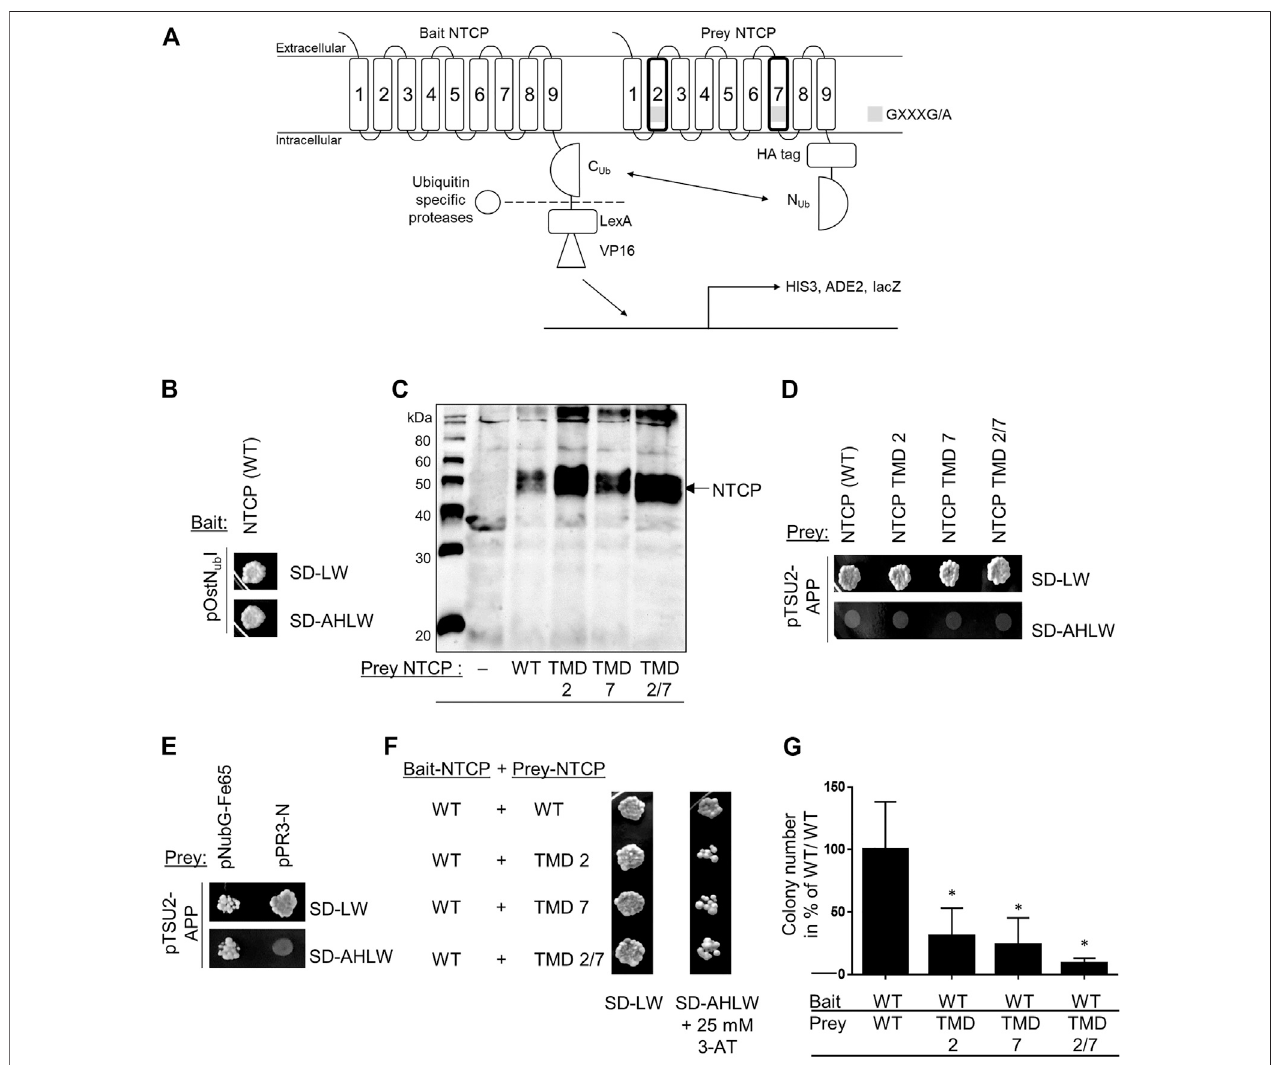
FIGURE 1 | Functional NTCP homodimerization in the MYTH system. (A) The MYTH system is based on the fusion of the C-terminal part of ubiquitin with the N-terminalpart leadingtothe separation ofthetranscriptional factors LexA-VP16 byubiquitin-speci fi cproteases and activation ofgenesresponsiblefor thesynthesis of histidine and adenine. (B) Yeast cells were co-transformed with the wild-type (WT) NTCP-C ub -LexA-VP16 bait and the pOstN ub I control prey constructs. Growth was analyzed on SD-LW plates (lacking leucine and tryptophan) and on SD-AHLW plates (additionally lacking adenine and histidine). (C) Western blot analysis of the wild-type and mutant prey NTCP-HA-N ub G fusion proteins with an anti-HA antibody. (D) Co-transformation of the wild-type and mutant NTCP prey constructs with the pTSU2-APPcontrolconstructanddrippingonSD-LWandSD-AHLWplates. (E) Interactioncontrolafterco-transformationofthepTSU2-APPcontrolconstructwiththe pN ub G-Fe65preyconstruct(positivecontrol)orwiththepPR3-Nemptyvector(negativecontrol)anddrippingonSD-LWandSD-AHLWplates. (F) Co-transformationof the NTCP wild-type bait construct with the indicated wild-type or mutant NTCP prey constructs and dripping on SD-LW (co-transformation control) and SD-AHLW (protein-protein interaction assay) plates. The SD-AHLW plates additionally contained 25 mM 3-AT to suppress unspeci fi c interactions. (G) The bait-prey co- transformationsshownin (F) werecompletelyplatedon10 cmSD-AHLWplatescontaining25 mM3-ATandthetotalnumberofcolonieswascountedusingOpenCFU (Geissmann, 2013). Data represent means ± SD of four independent experiments. *Signi fi cantly different from control (NTCP(WT)-bait/NTCP(WT)-prey) with p < 0.01 (one-way ANOVA with Dunnett ‘ s multiple comparison test).